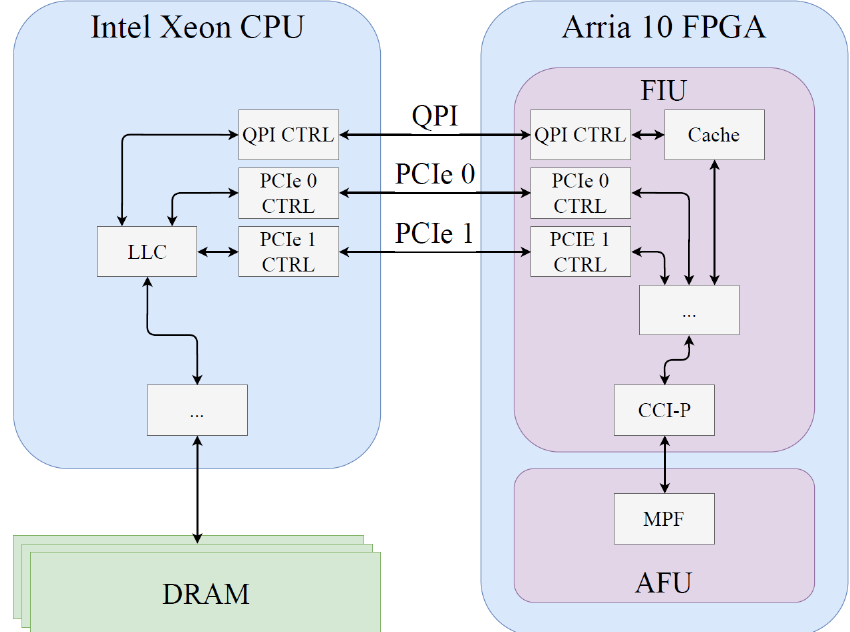
Figure 1. HARPv2 heterogeneous architecture, consisting of an Intel Xeon CPU and Arria 10 FPGA with QPI and PCIe interconnects. The QPI and PCIe channels are respectively 16 and 8 bit